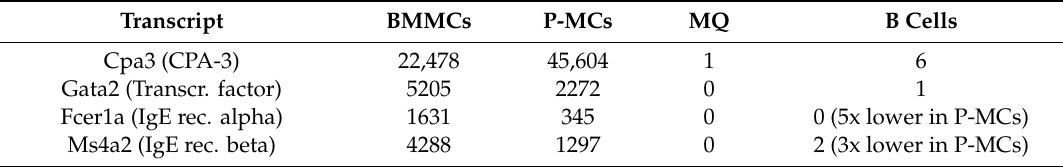
Table 2. Transcripts found at high levels in both BMMCs and mature peritoneal MCs but at low levels in MQ and / or B cells. The table depicts the number of reads for each transcript. The right column depicts fold-di ff erences in transcript levels between P-MCs vs. BMMCs for a few selected